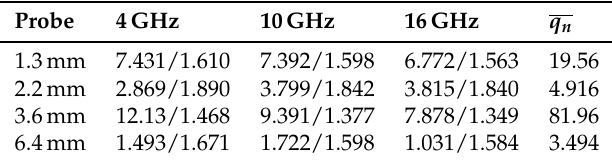
Table 4. Optimized power function parameters from Equation (7), expressed as q n / α n for each frequency with frequency-averaged coefficient ( q n ) for α n = 2.